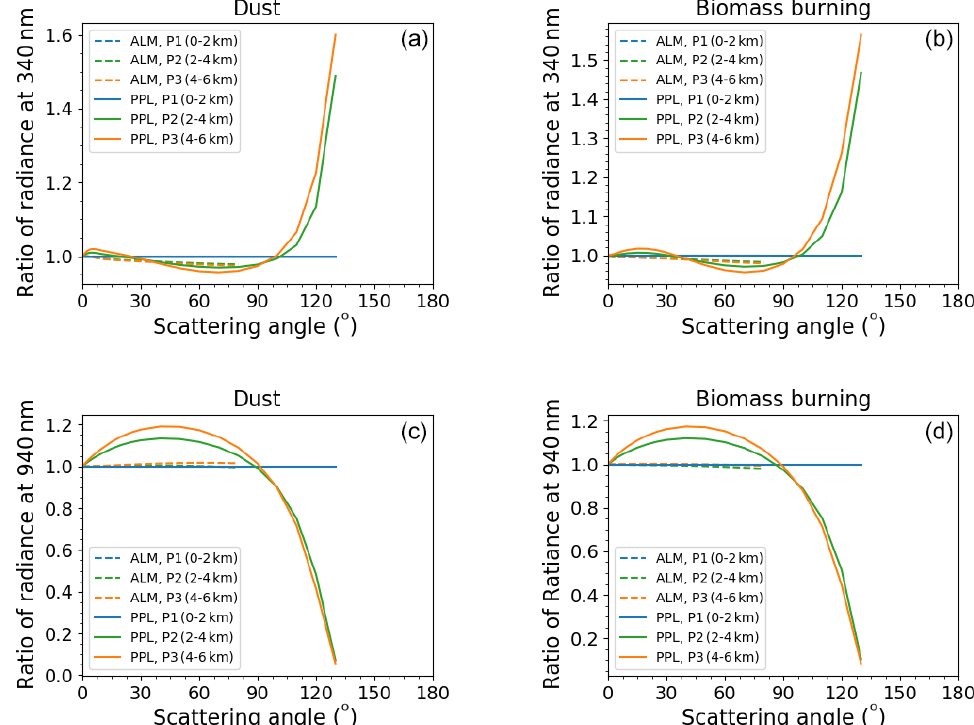
Figure 5. Ratio of the simulated diffuse radiances at 340nm (a, b) and 940nm (c, d) with different aerosol vertical profiles of 0 to 2km (blue), 2 to 4km (green), and 4 to 6km (orange) to those with an aerosol vertical profile of 0 to 2km. The left and right panels are the simulations for the dust and biomass burning models, respectively. The solid and dashed lines are the simulations for the almucantar (ALM) and principal plane (PPL) geometries,